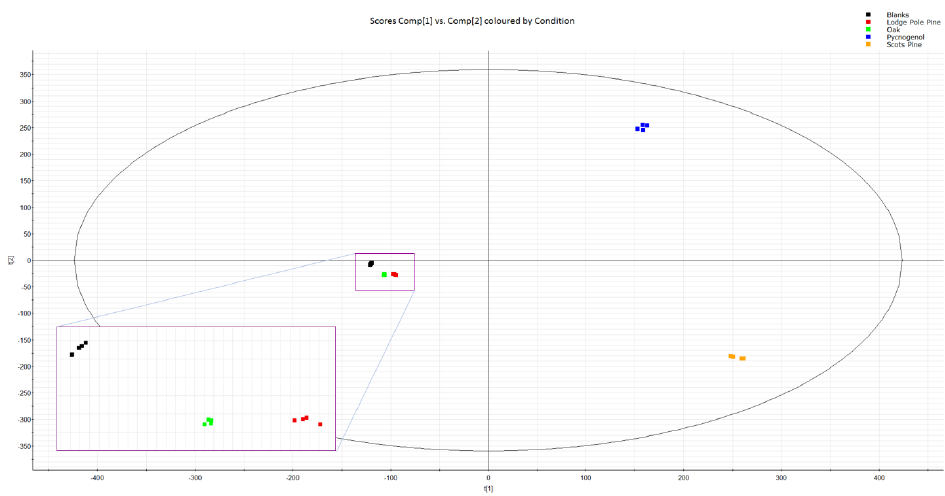
Figure 2. Scores plot with Pareto scaling showing tight clustering of the bark extract sample replicates and separation between bark types including an expanded area view of the more closely situated clusters.